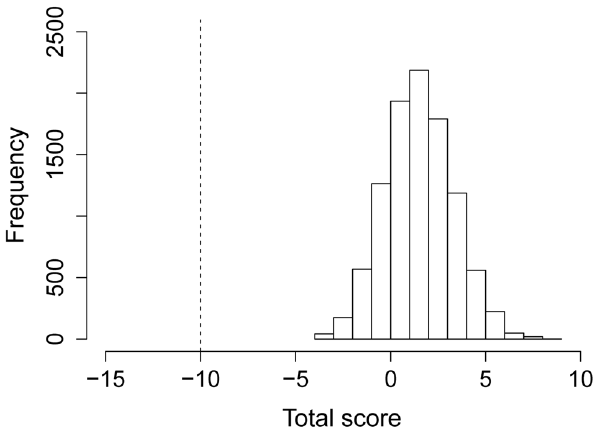
Fig. 1. A histogram illustrating the results of a bootstrap analysis to control for sample size and determine whether European and Mongolian sample sets differed in their capacity to identify a population bias toward titres against HPAIV versus LPAIV. The analysis randomly selected 25 serum samples (equivalent to the number of European sera assessed) from the 182 Mongolian sera. Individual sera were scored + 1 for HPAIV-biased sera, 2 1 for LPAIV-biased sera and 0 for ambiguous sera. The analysis was repeated 10,000 times and bars represent the frequency of total scores. The vertical dashed line represents the equivalent score for the European sample